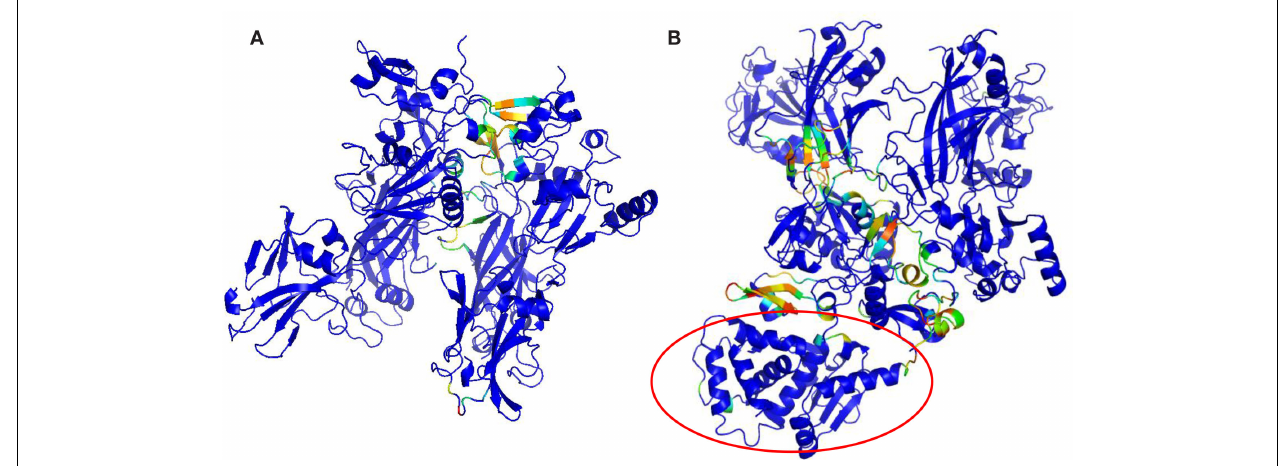
FIGURE 7 | P maps on protein structures: (A) 3HVD, octamer of PA; (B) 3KWV, PA–PA–LF complex